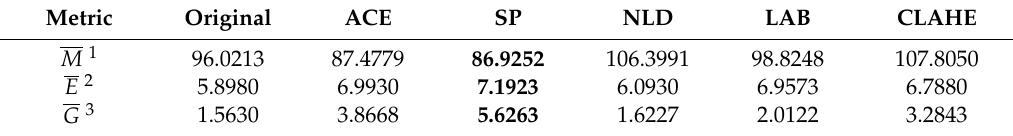
Table 3. Average metrics for the sample image “CalaMinnola1” enhanced with all algorithms. Metric Original ACE